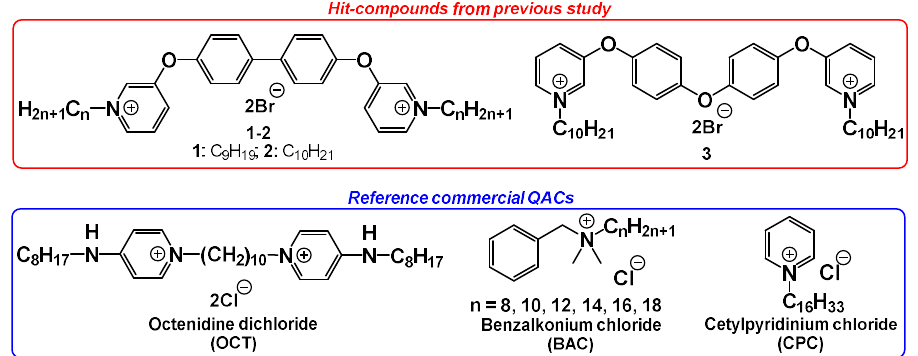
Figure 1. Tested bis-QACs: hit compounds 1 – 2 from ref. [15], and 3 from ref. [16].